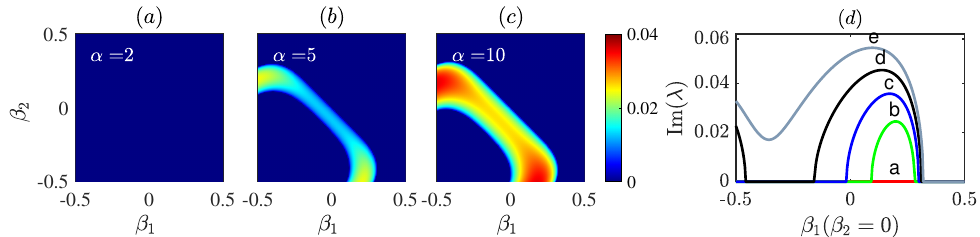
Figure 3. MI analysis for NNLSE with PT -symmetric potential according to Equations (17) and (18). ( a – c ): imaginary part Im( λ ) of eigenvalues as functions of dimensionless wavenumber β 1 and β 2 for nonlocal nonlinearity α = 2, 5, and 10 (here σ = 0.7); ( d ) cross section of the eigenvalue spectrum at β 2 = − 0.5 as a function of β 1 corresponding to α = 2, 3, 5, 10, and 20 (i.e., from lines a to